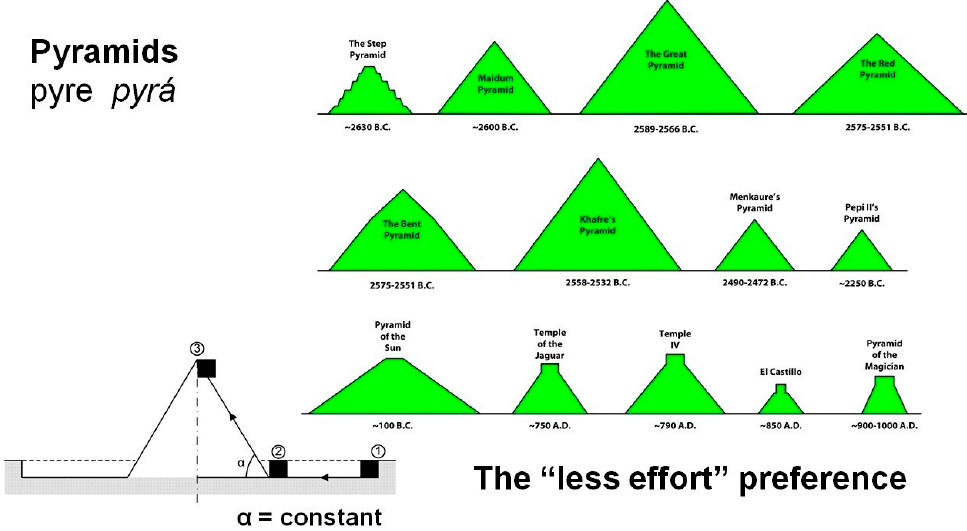
Figure 2. Pyramids appear to have the same shape because shapes in this narrow range correspond to dry-stone construc- tions that require less effort